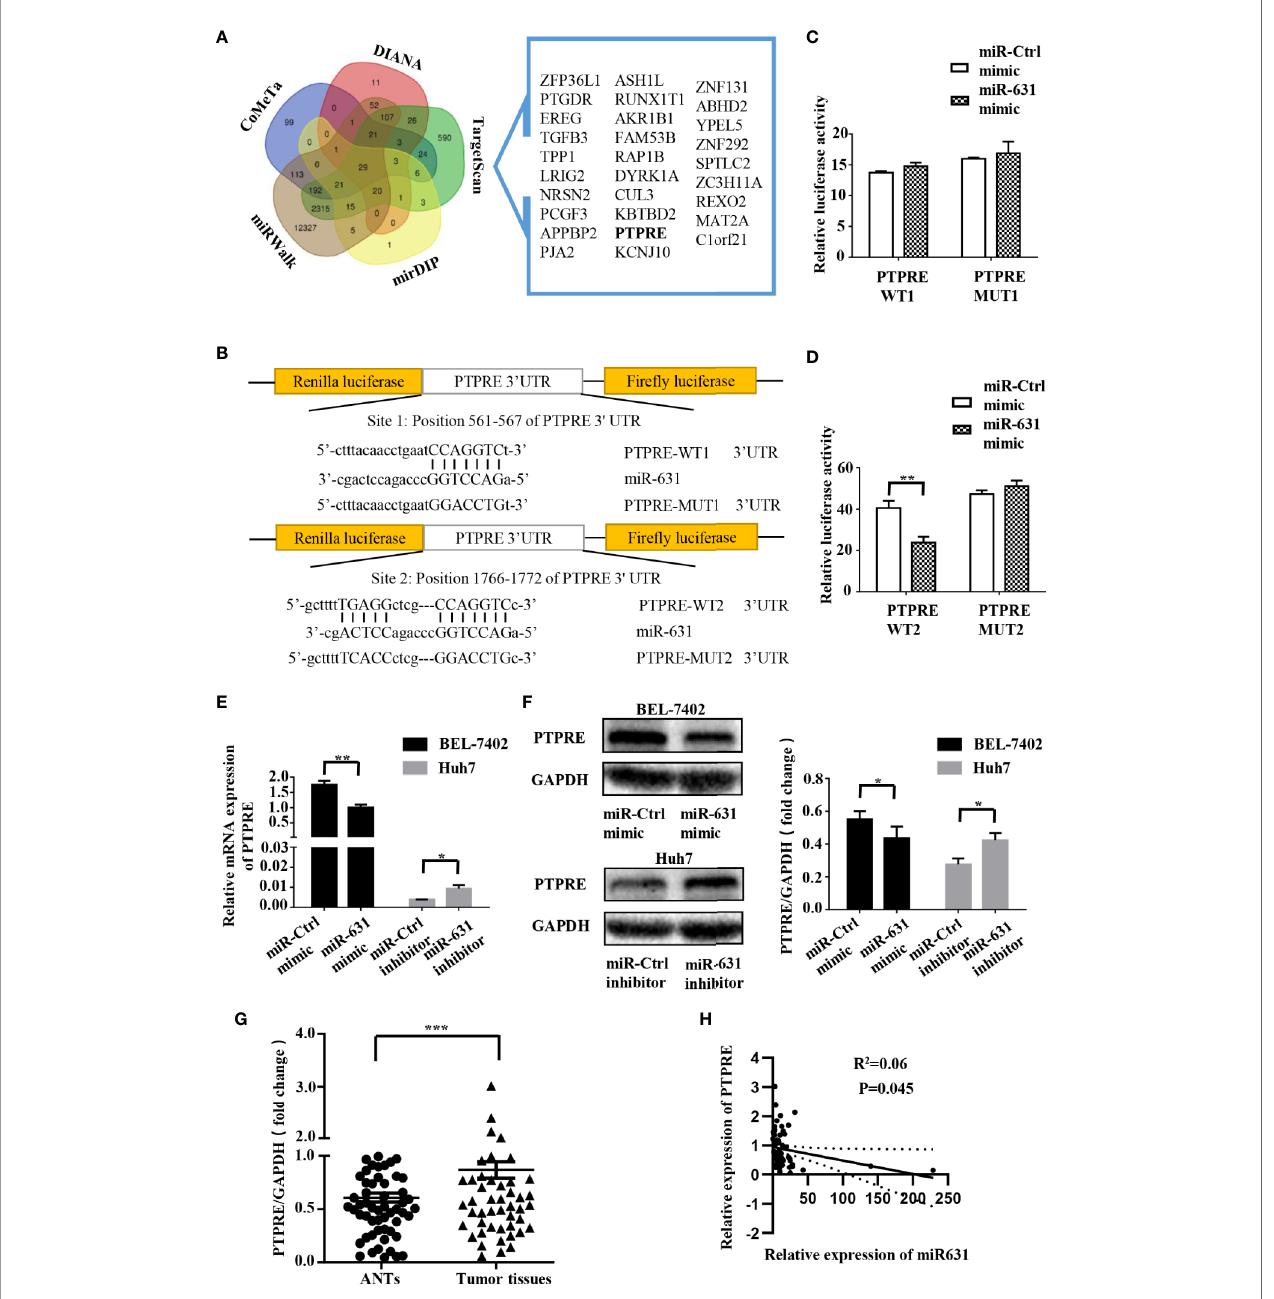
FIGURE 3 | PTPRE is a direct downstream target of miR-631 in HCC cell lines. (A) Venn diagram of fi ve databases that predicted downstream target of miR-631. The overlaps are shown. (B) The putative binding sites of miR-631 and the corresponding mutant sites in PTPRE 3 ′ -UTR. The diagram showed the positions of sites in psiCHECK-2-vector. (C, D) Relative luciferase assay in HEK293 cells where miR-631 mimic was co-transfected with psiCHECK-PTPRE wild-type or psiCHECK- PTPRE mutant vector of sites 1 and 2. (E, F) The mRNA and protein expression levels of PTPRE in BEL-7402 and Huh7 cells after being transfected by miR-631 mimic and miR-631 inhibitor, respectively. (G) The protein expression of PTPRE in 64 HCC tissues. (H) The correlation between the expression of PTPRE and miR- 631 in HCC tissues. The concentration of mimic and inhibitor is 50 nM. *P < 0.05; **P < 0.01; ***P < ( Figure 3D ). These results suggested that miR-631 could target mRNA of PTPRE on the binding site 2 directly.